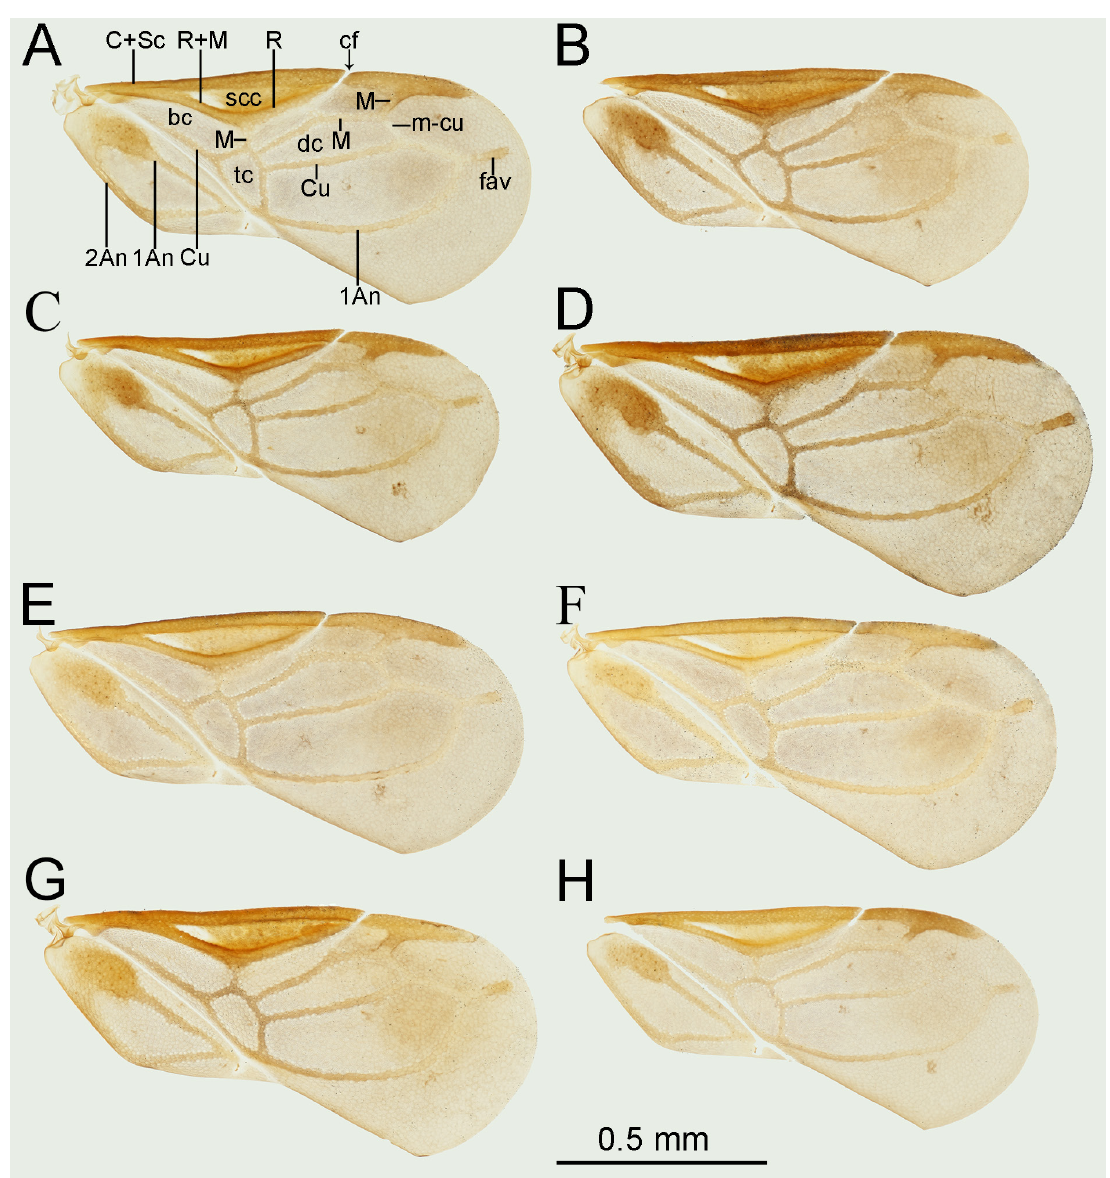
Fig. 26. Forewings of Kokeshia spp., dorsal views. A . K. acutiformis sp. nov., paratype, ♂ (SYSBM). B . K. baii sp. nov., paratype, ♂ (SYSBM). C . K. bui sp. nov., paratype, ♂ (SYSBM). D . K. caii sp. nov., paratype, ♂ (SYSBM). E . K. drepanoides sp. nov., paratype, ♂ (SYSBM). F . K. hilli sp. nov., paratype, ♂ (SYSBM). G . K. hsiaoi Ren & Zheng, 1992, ♂ (SYSBM). H . K. pengae sp. nov., paratype, ♂